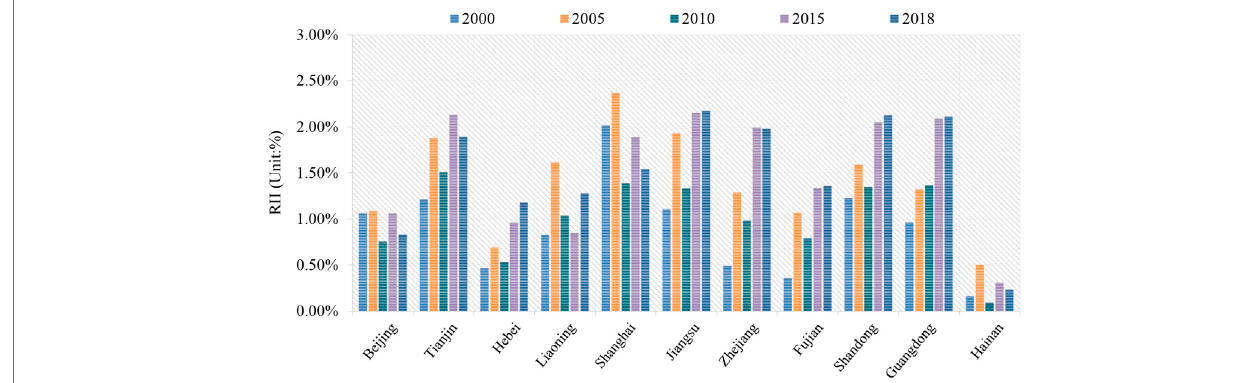
FIGURE 3 | Regional comparison of RII in eastern China.